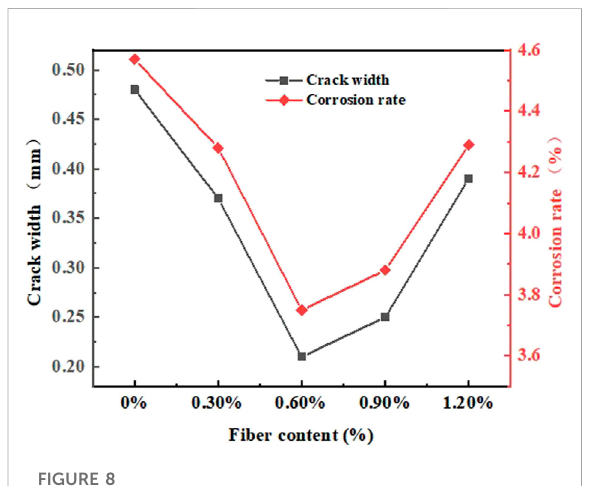
FIGURE 8 Corrosion rate and crack width with fi ber content.